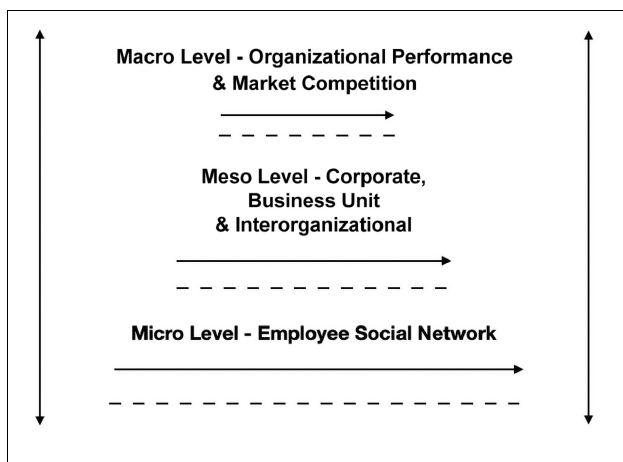
FIGURE 1 | Levels of analysis.